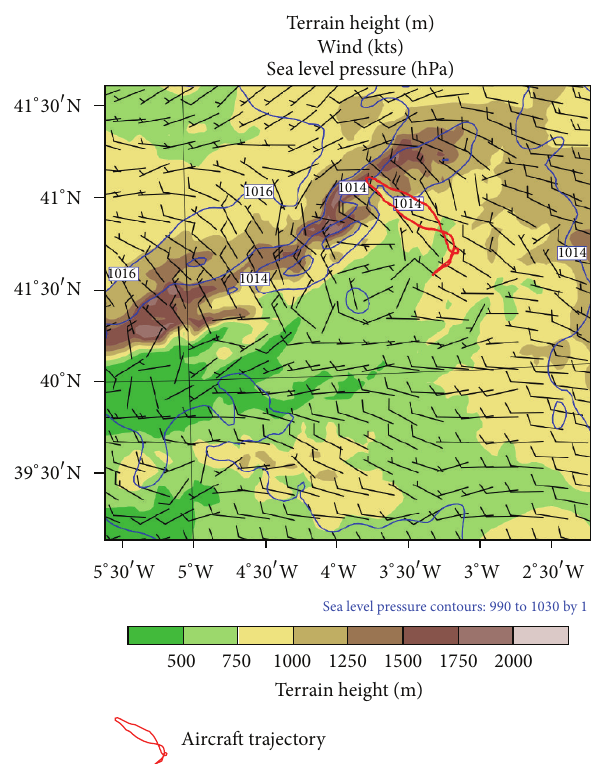
Figure 11: Terrain height, sea level pressure, and surface wind in domain D03. Aircraft trajectory has been